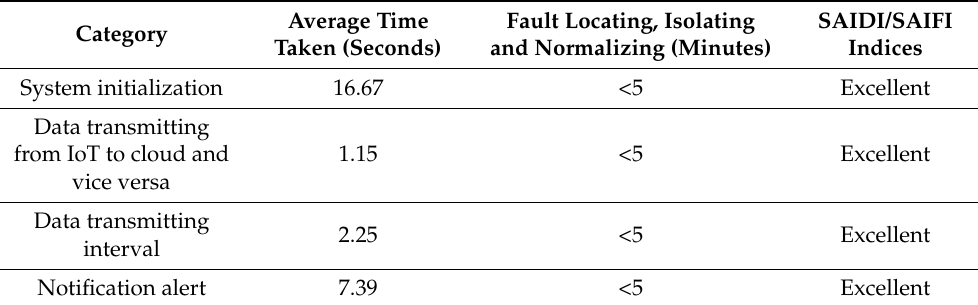
Table 1. Proposed system